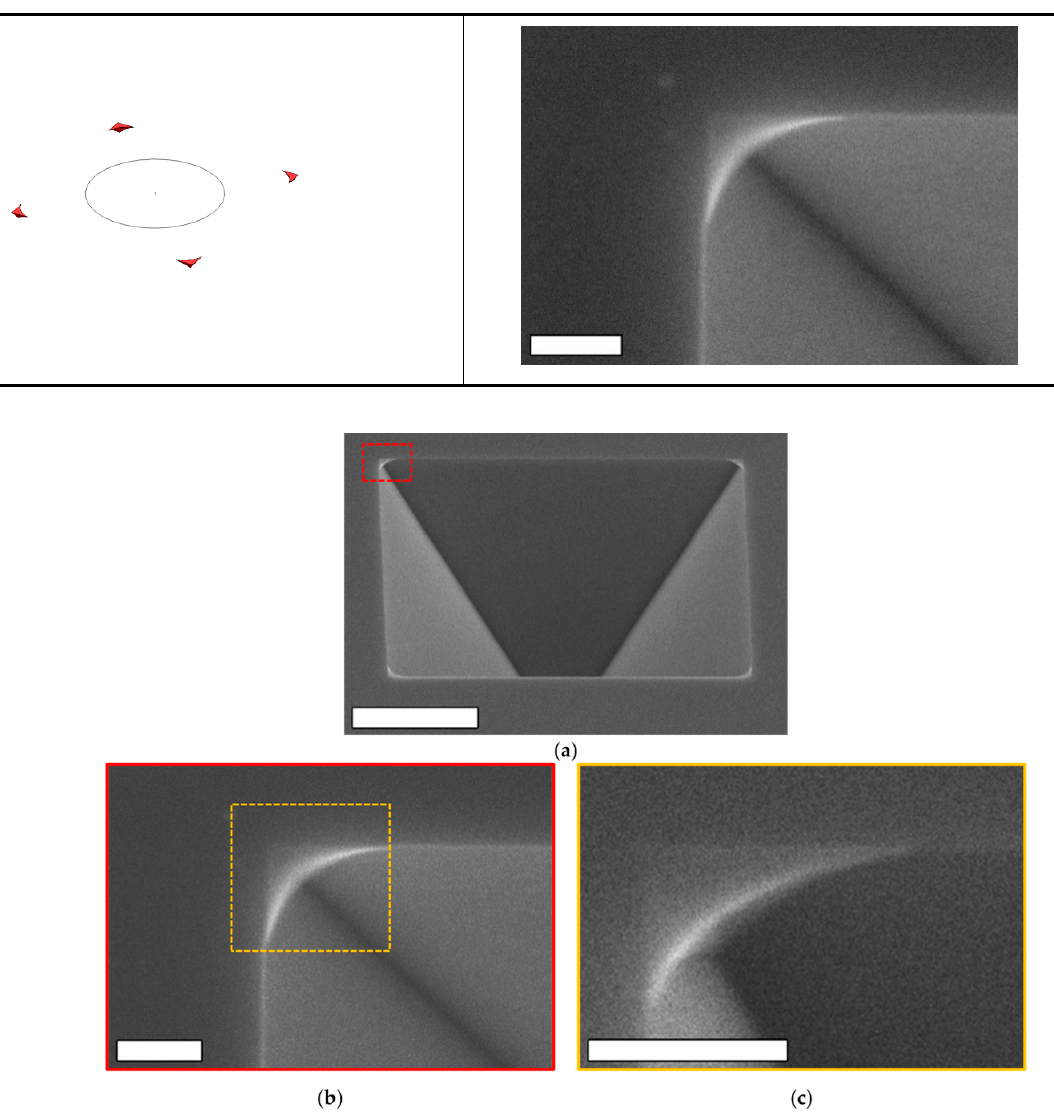
Figure 11. Tilted SEM ( a – c ) images of the Si 3 N 4 corners of the last stage of the corner lithography. ( b , c ) Zoomed-in images at the corner indicated by the dashed rectangles. Scalebars: ( a ) 2 µm and ( b , c ) 200 nm.